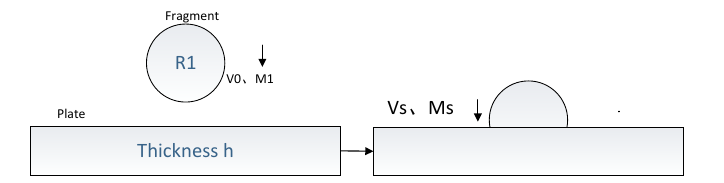
Figure 1. Fragment impacting target plate.